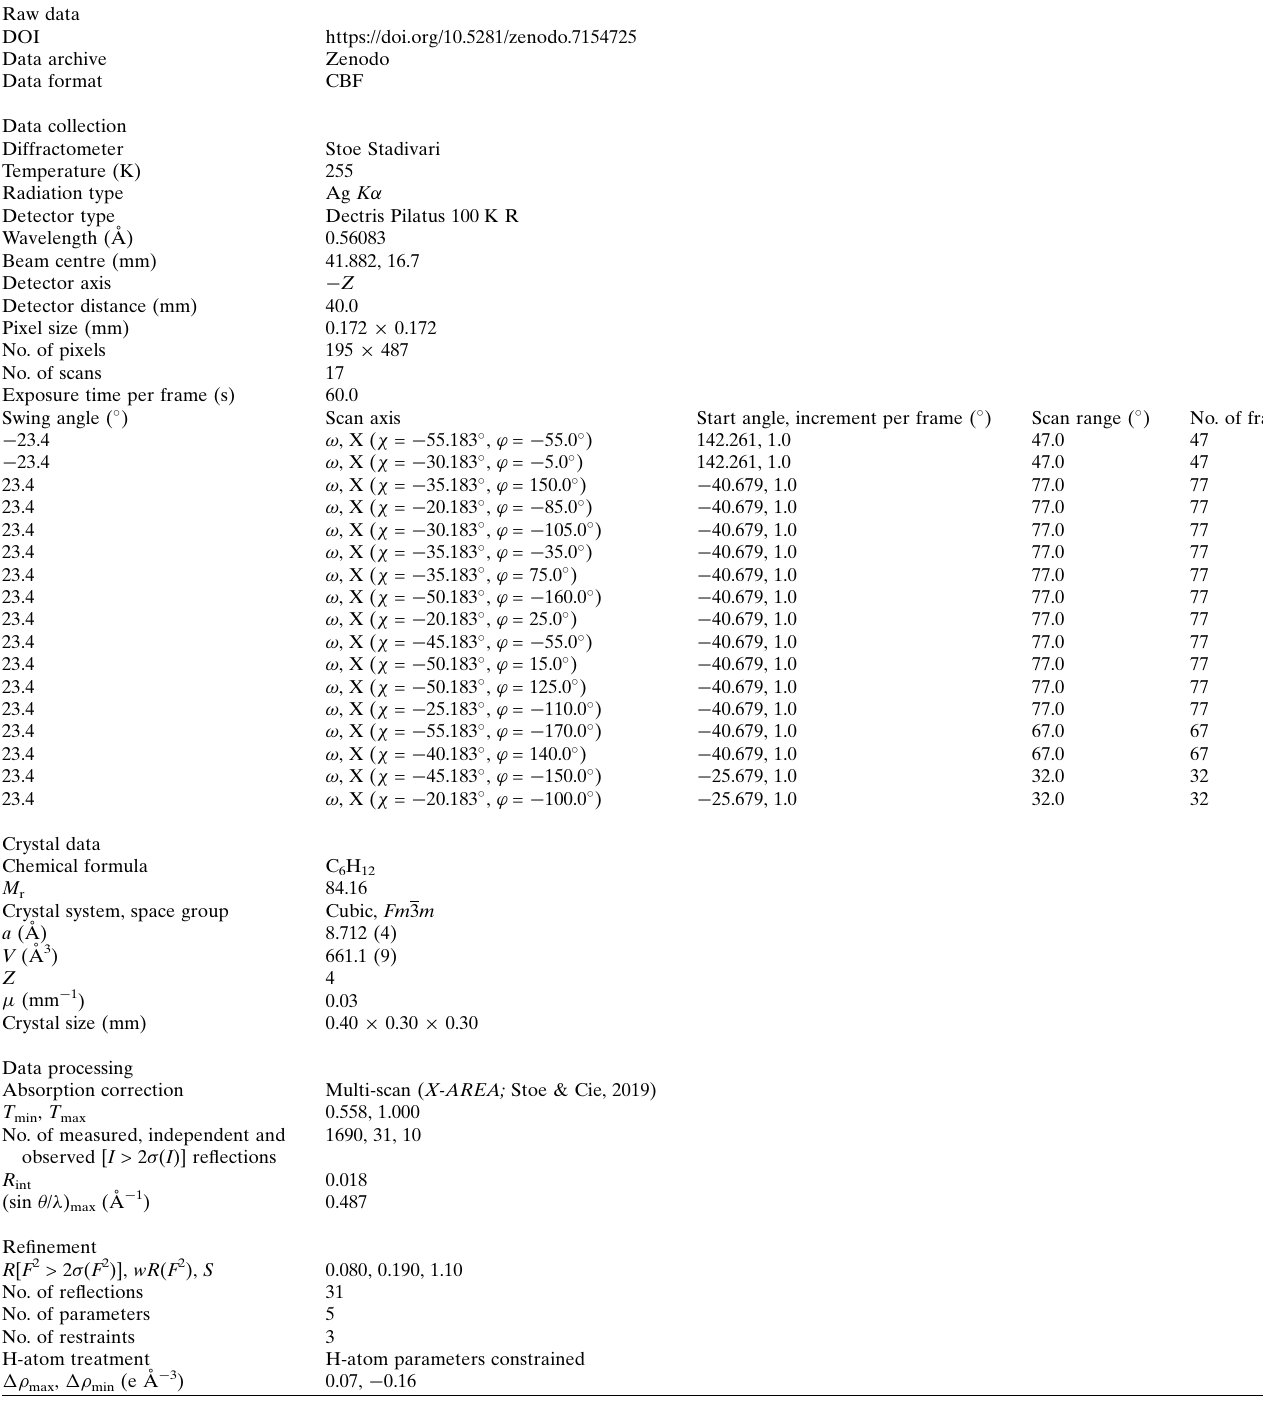
Table 1 Experimental